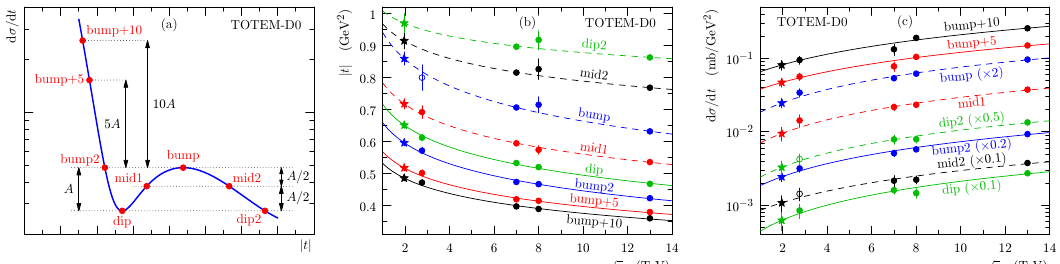
Figure 3: ( a ) Schematic definition of the characteristic points in the TOTEM differ- ential cross section data. ( b ) and ( c ) Characteristic points in | t | and d σ/ dt from TOTEM measurements at 2.76, 7, 8, and 13 TeV (circles) as a function of olated to Tevatron center-of-mass energy (stars). (Figure reproduced from Ref. [ 2 ] ). measurements using a double exponential fit ( χ 2 = 0.63 per